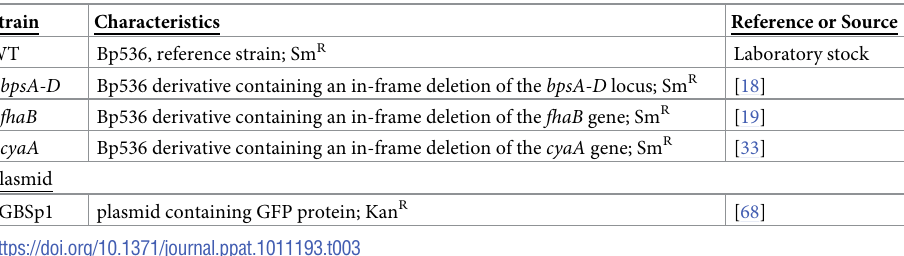
Construction of green fluorescent protein (GFP)-labeled bacteria